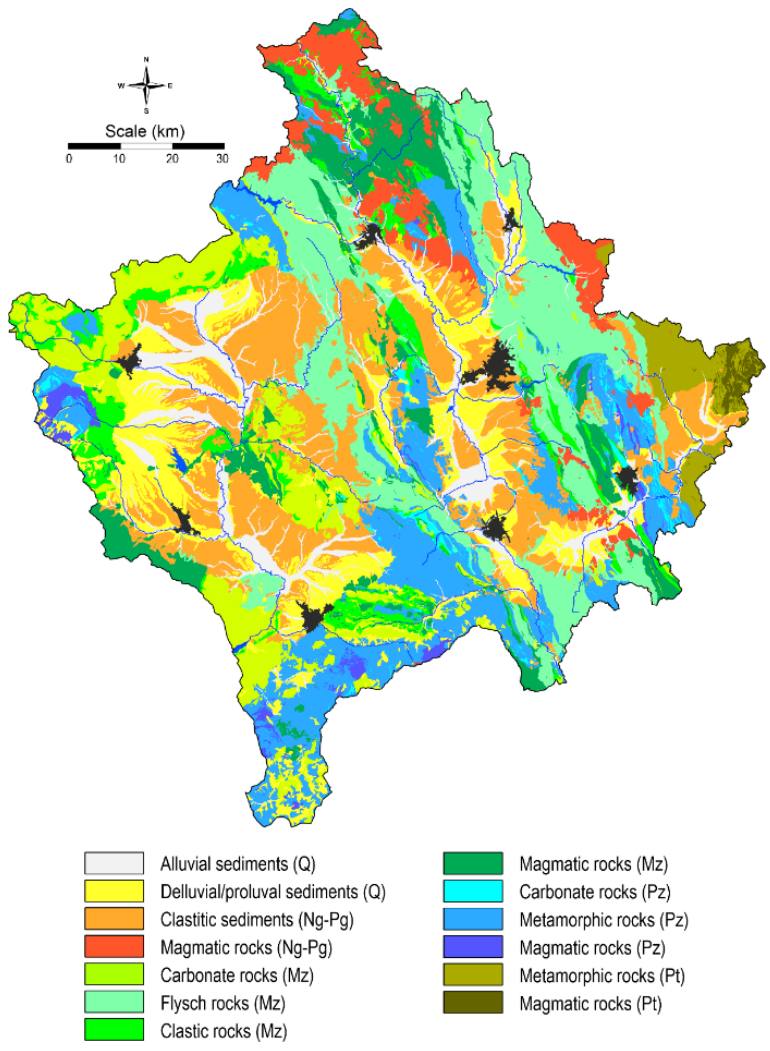
Figure 1. The geological map of